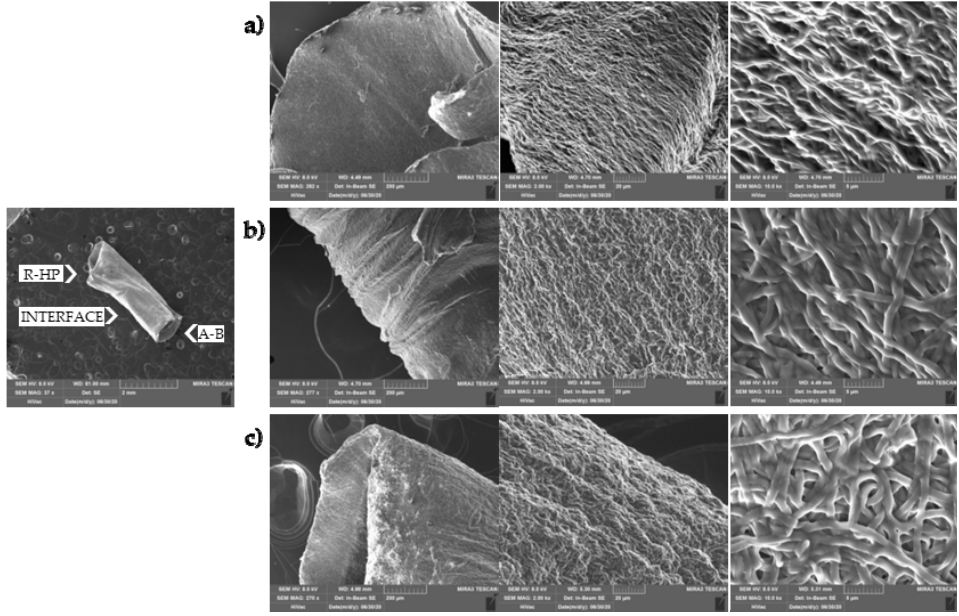
Figure 3. SEM (0.02, 0.2, 2, and 10 kx, left, middle, and right panels, respectively) images of the tubular scaffold after hydration in PBS for 6 days: a) A-B part; b) interface region between the A-B and R-HAP parts; c) R-HAP part.